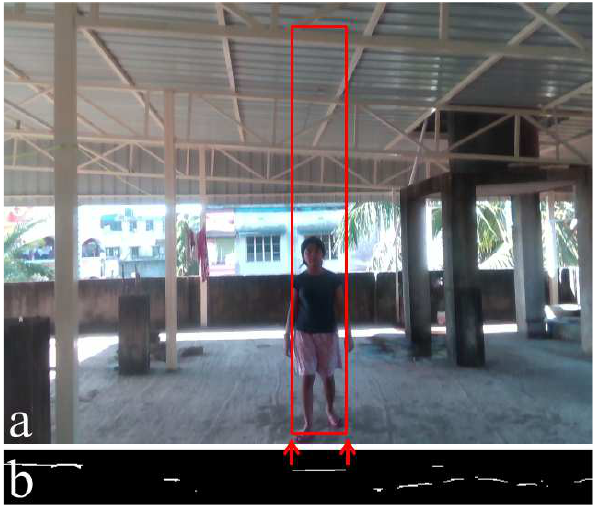
Figure 6. Height estimation of an obstacle using VbOAD [28]. ( a ) A snapshot captured with D435i along with the estimated height of the obstacle (the person). ( b ) Corresponding thresholded u-depth